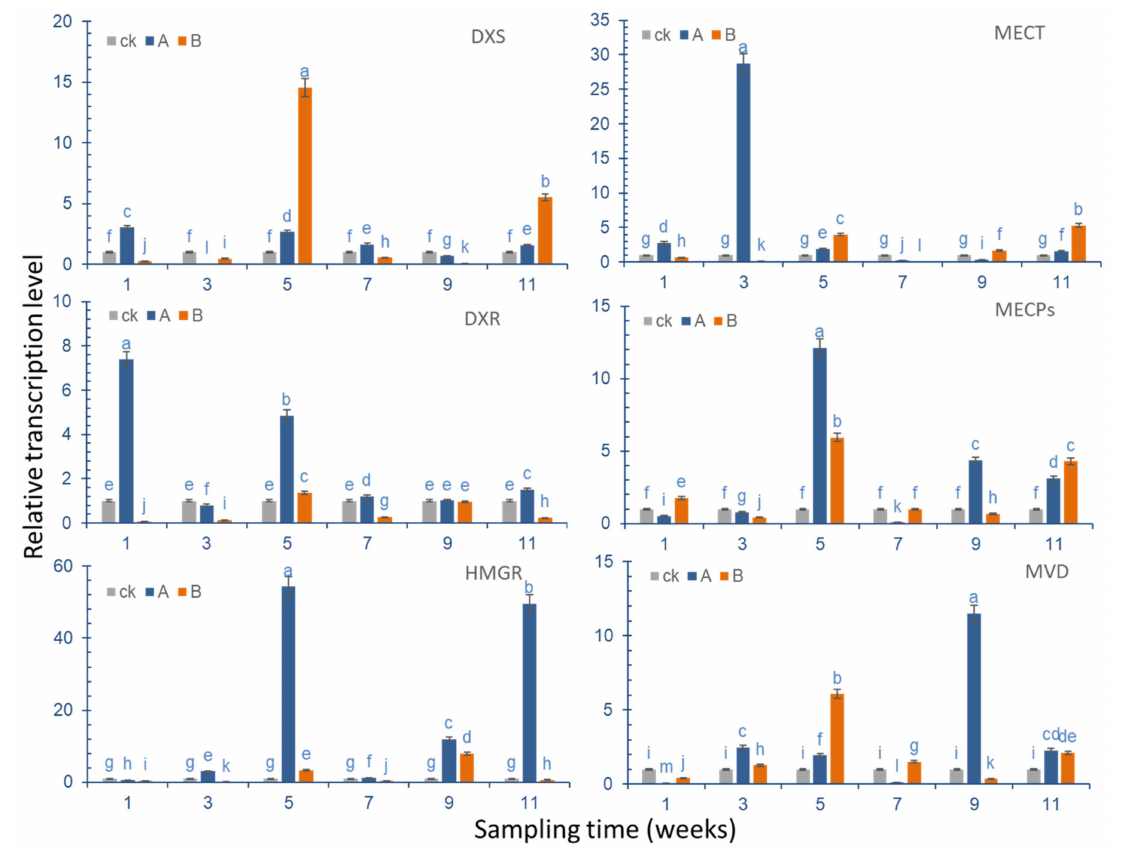
Figure 9. Relative expression level of six differentially expressed genes in the ginkgo terpene lactone synthesis pathway at different sampling points. Note: CK. control group; A. foliar spraying; B. root pouring. The lowercase letters a–m on the bar reflects the 5% significant